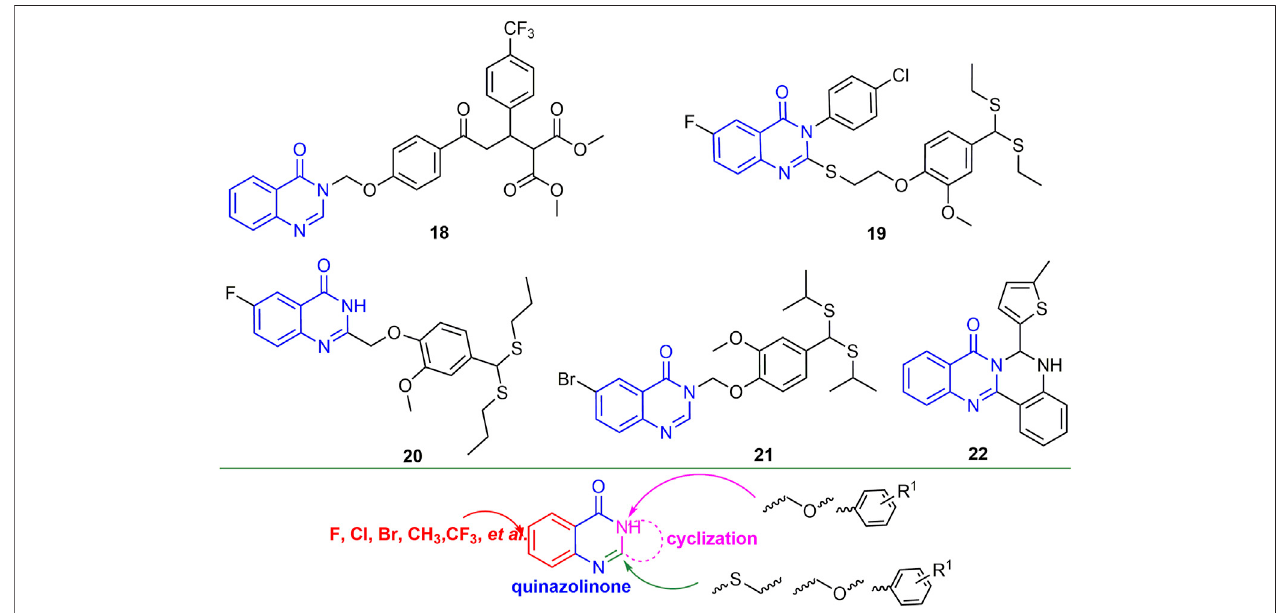
FIGURE 6 | Structures of representative quinazolinone derivatives in antiviral activities.